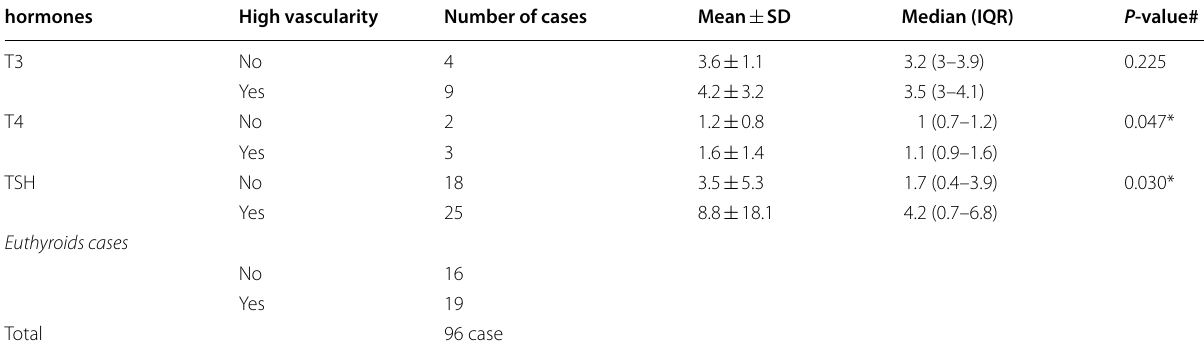
Table 2 Relation between high thyroid gland vascularity and thyroid hormonal level in studied cases: